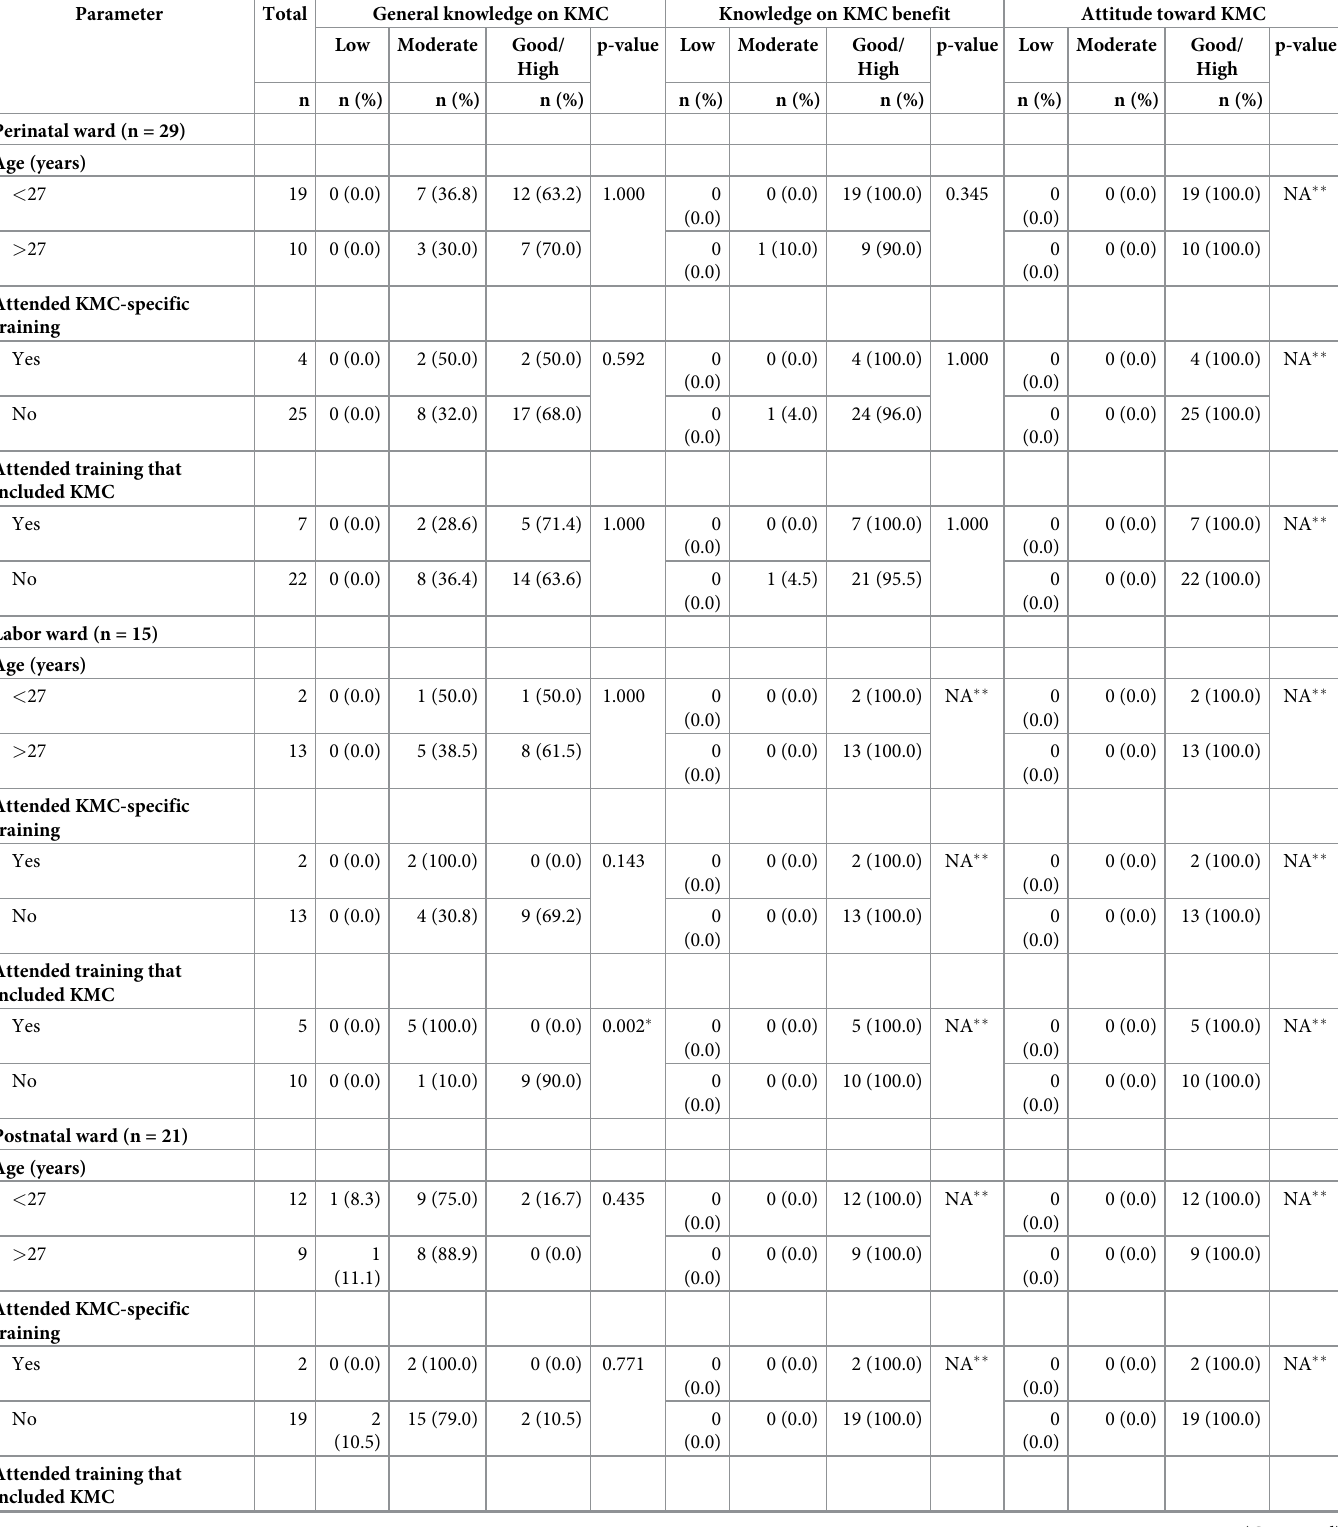
Table 3. Knowledge and attitude toward kangaroo mother care (KMC) according to age and training